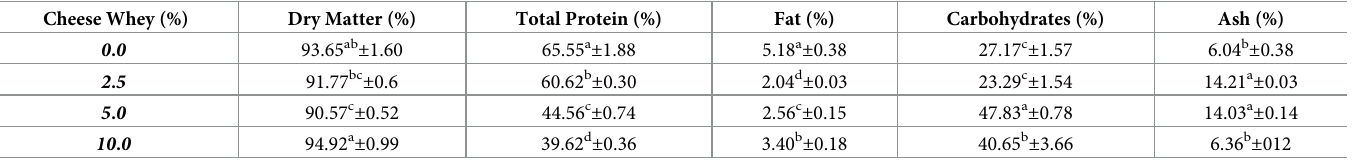
Different letters indicate significant differences for different treatments (p <